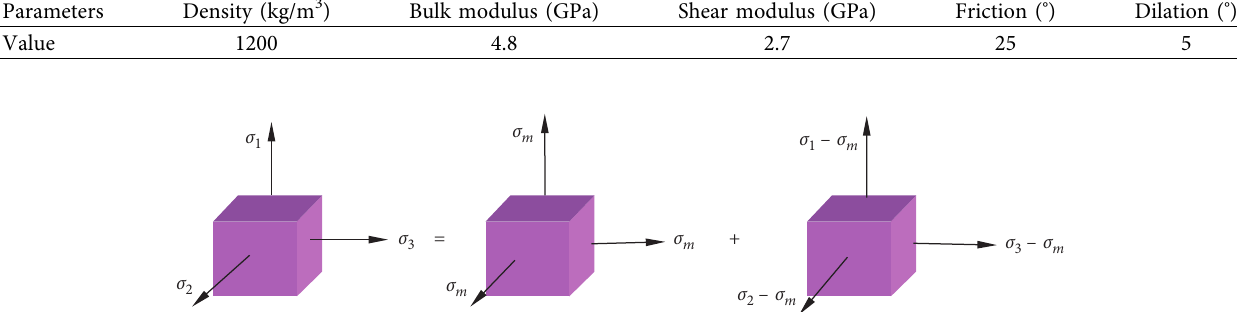
Figure 15: Three-dimensional stress state of surrounding rock